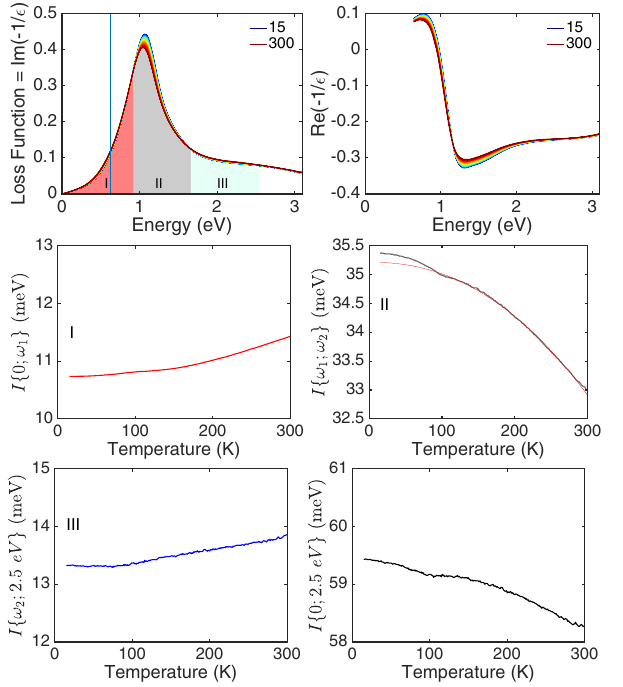
FIG. 13. Sample Bi2212-81-OD. Caption details as in Fig. 8. The value of the fitted exponent α is 1.6.